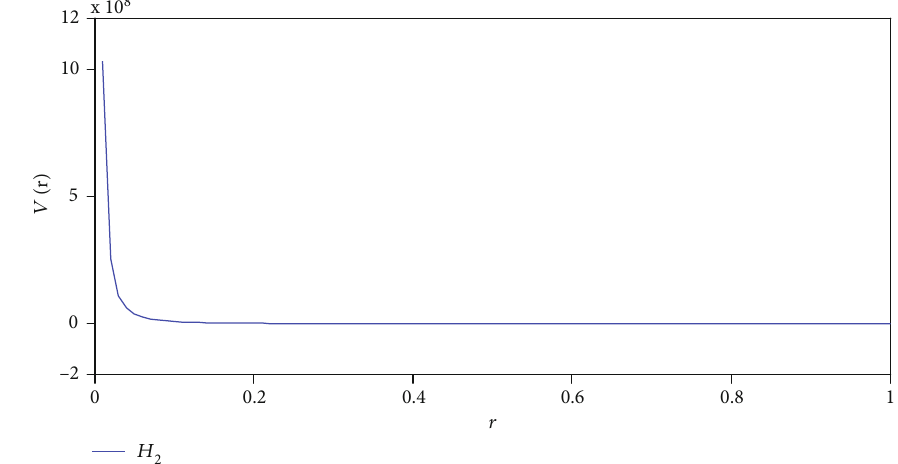
Figure 1: The Deng-Fan potential ð eV Þ in terms of r ð A 0 Þ for H